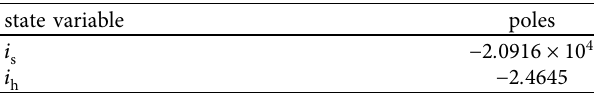
Table 3: Poles of reduced system matrix A variables i and i of transformer s h